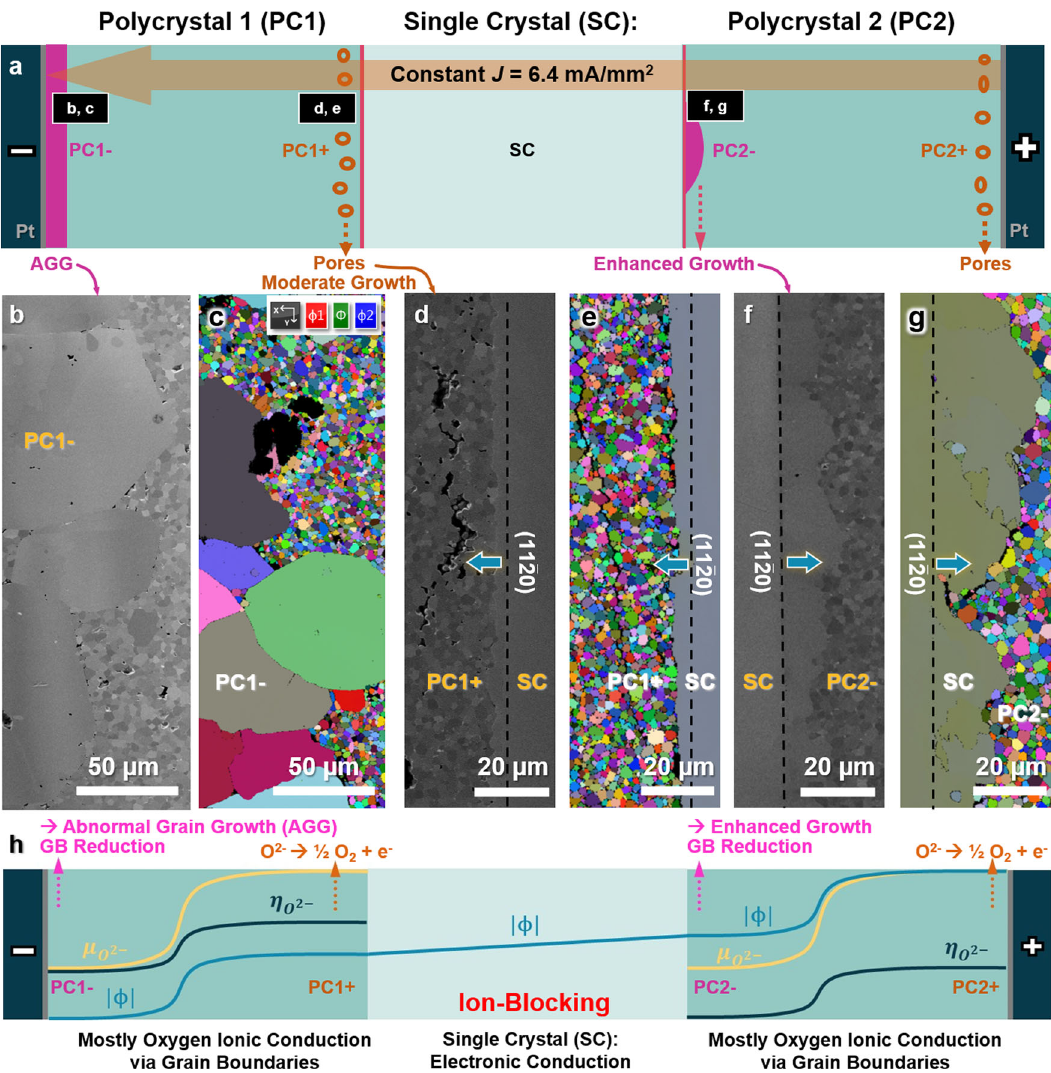
Fig. 2 Microstructure of a Bi 2 O 3 -doped ZnO sandwich specimen isothermally annealed under a constant applied current. a A schematic illustration of this PC1/SC/PC2 sandwich specimen. Enhanced or abnormal grain growth takes place in the reduced PC1 – and PC2 – regions. Cross-sectional scanning electron microscopy (SEM) micrographs and electron backscatter diffraction (EBSD) Euler maps of b , c abnormal grain growth (AGG) near the cathode in the reduced PC1 – region, as well as d , e moderate migration of the oxidized PC1 + /SC interface vs. f , g enhanced migration of the reduced SC/PC2 – interface. Dashed lines indicate the original positions of the SC/PC interfaces. See Supplementary Fig. 2 for quantitative measurements of migration distances of both PC1 + /SC and SC/PC2 – interfaces (in comparison with those in a reference sandwich specimen without an applied electric fi eld) and Supplementary Figs. 3 – 5 for addition EBSD maps. h Schematic pro fi les of electric ( ϕ ), chemical ( μ O 2 (cid:2) ), and electrochemical ( η O 2 (cid:2) ) potentials vs. locations. See Supplementary Fig. 1 for further